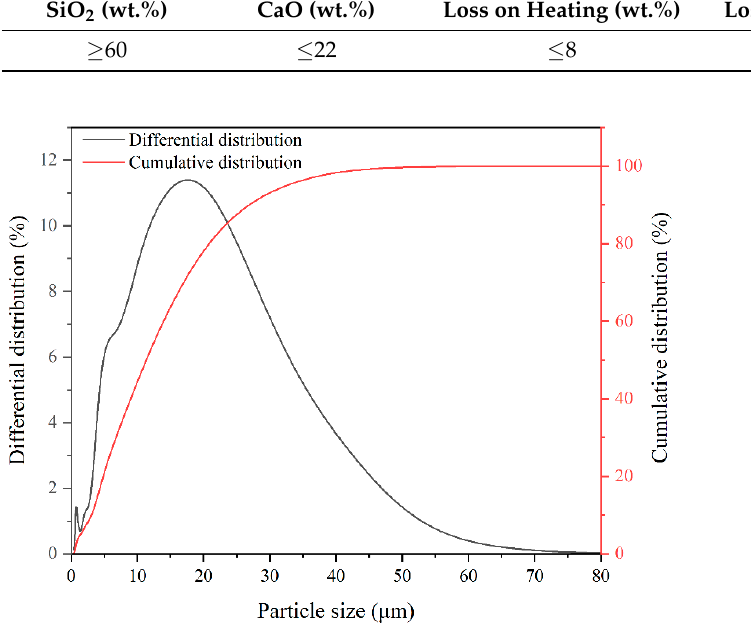
Figure 1. Particle size distribution of ultrafine calcium silicate.